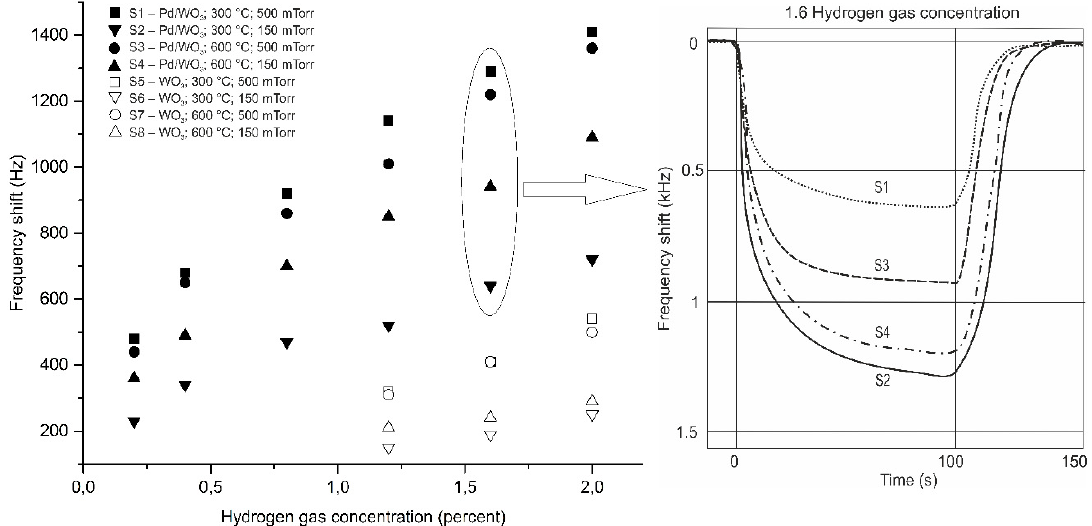
Figure 6. ( left ) Frequency shifts of the WO 3 –based sensors (open symbols) and Pd/WO 3 -based sensors (closed symbols) for various hydrogen gas concentrations. ( right ) Example of Pd/WO 3 sensor response towards 1.6% H 2 gas concentration at RT.